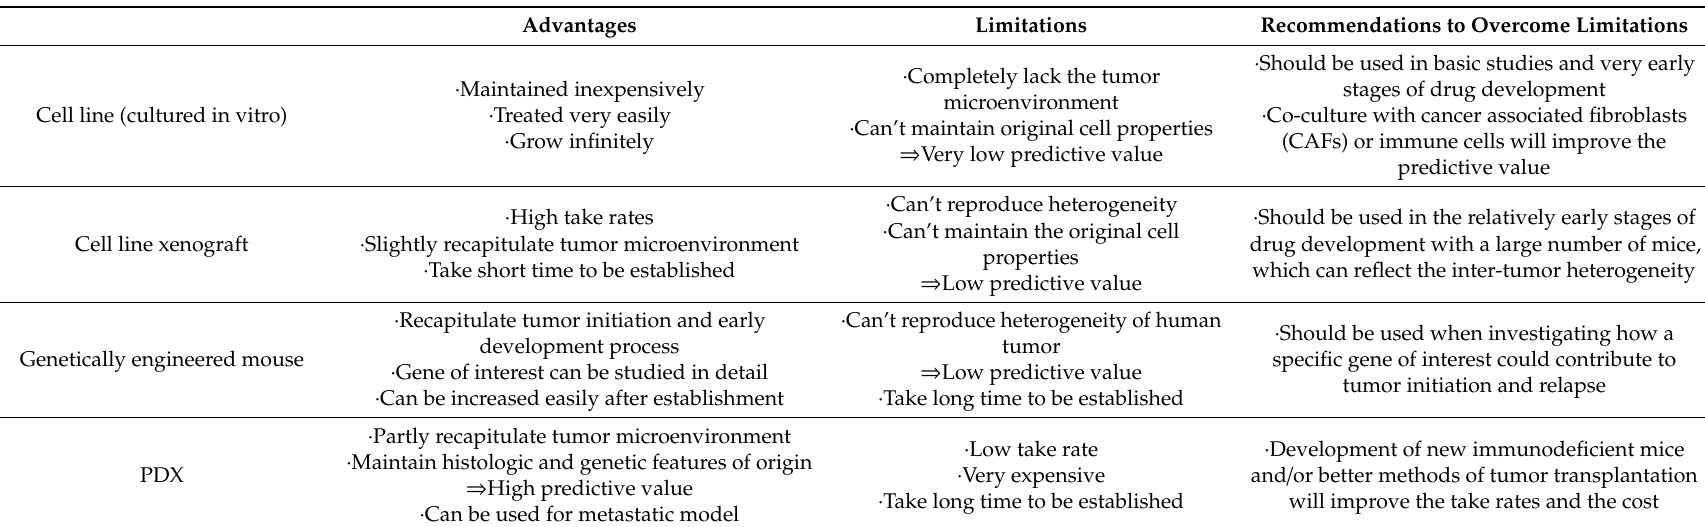
Table 1. Advantages and limitations of each cancer